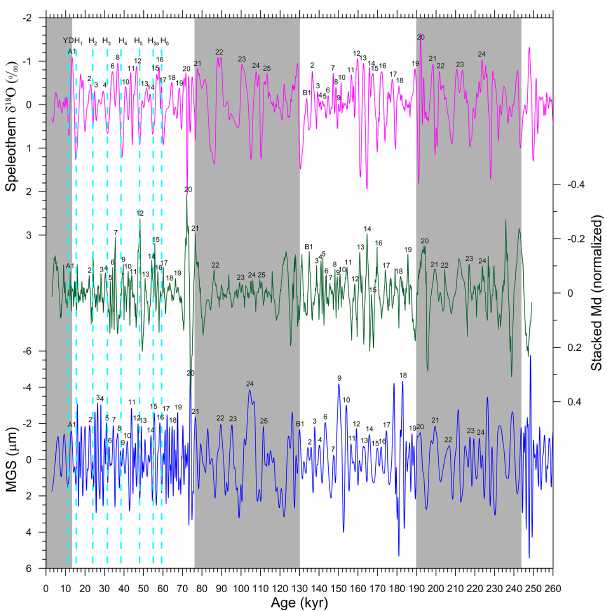
Figure 7. Comparison of millennial-scale variations among Gulang MGS (blue), CHILOMOS stack Md (green; Yang and Ding, 2014) and Sanbao/Hulu speleothem δ 18 O (magenta; Wang et al., 2008; Cheng et al., 2009) records over the last two glacial–interglacial cy- cles. Cyan dotted lines are the YD and the Heinrich events identified among the three records and gray bars indicate interglacial periods. The numbers represent well-correlated Chinese interstadials identi- fied among the three